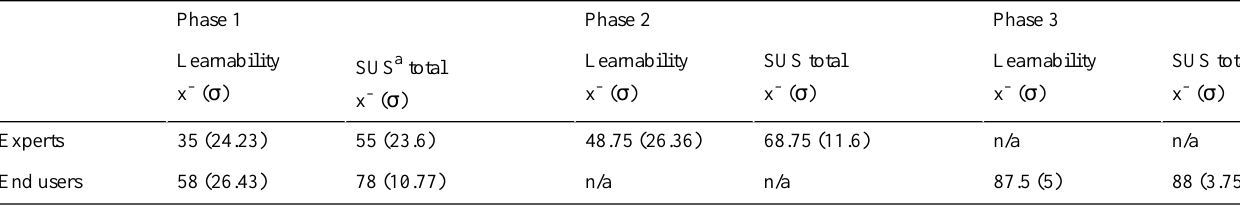
Table 17. System usability scale (SUS) metric, split into overall usability and learnability, captured at each